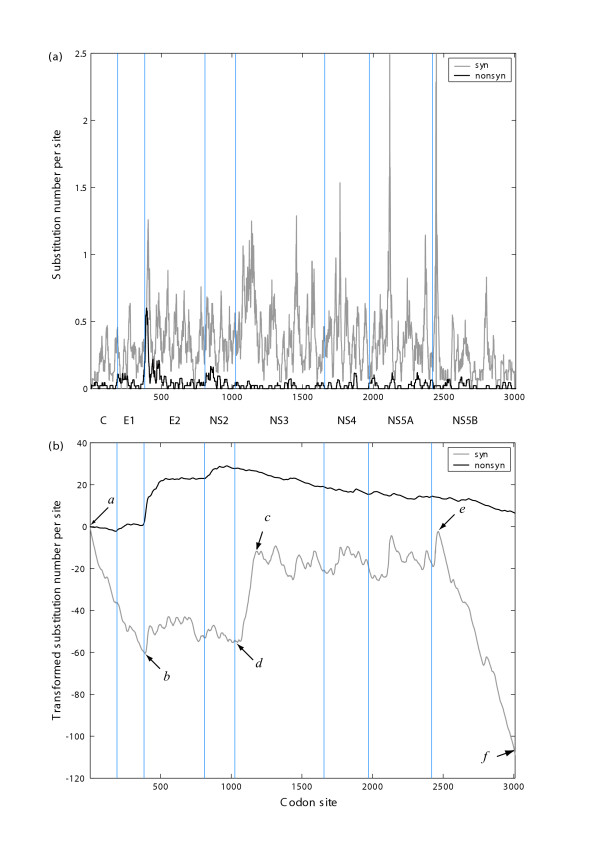
A comparison between sliding window and enhanced sliding window methods. Sliding window analysis of Ks and Ka for the concatenated coding regions of two hepatitis C virus strains, HCV-JS and HCV-JT. The number of codons for the C, El, E2, NS2, NS3, NS4, NS5A, and NS5B genes are 191, 192, 426, 217, 631, 315, 447, and 591, respectively. The different coding regions are separated by vertical lines. (a) illustrates the result of a normal sliding window analysis; (b) illustrates the result of the enhanced sliding window analysis. Beginnings and ends of regions poor in synonymous substitutions (slope < 0) are indicated by the arrows a and b (genes C and El) and e and f (gene NS5B). A region rich in synonymous substitutions (slope > 0) in gene NS3 is indicated by arrows c and d.